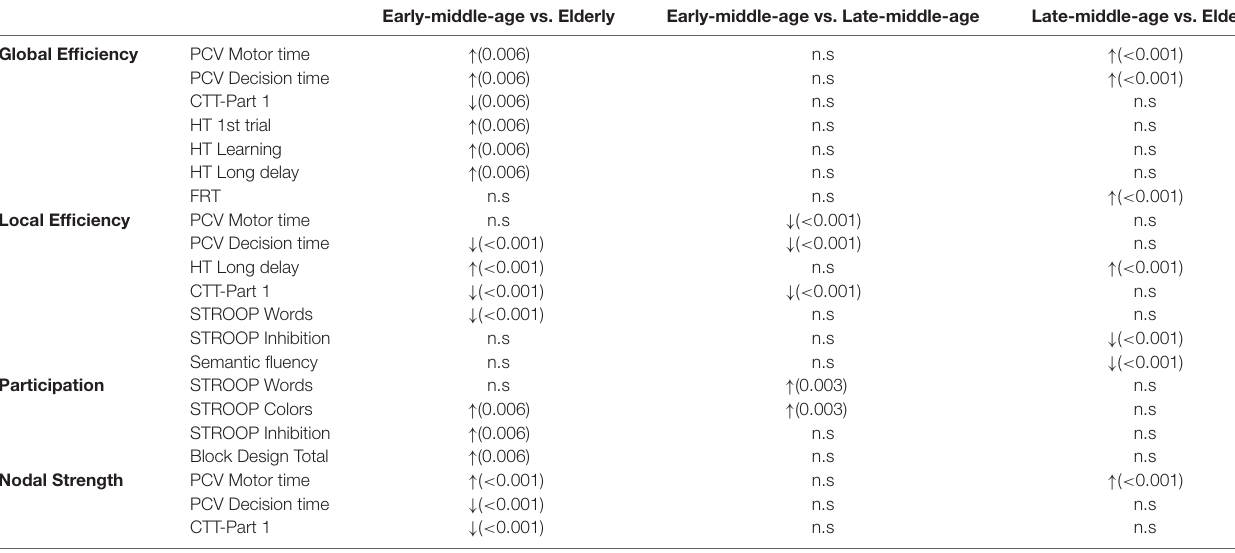
TABLE 4 | Differences in nodal network measures from the cognitive connectome across age groups. Early-middle-age vs. Elderly Early-middle-age vs. Late-middle-age Late-middle-age vs.